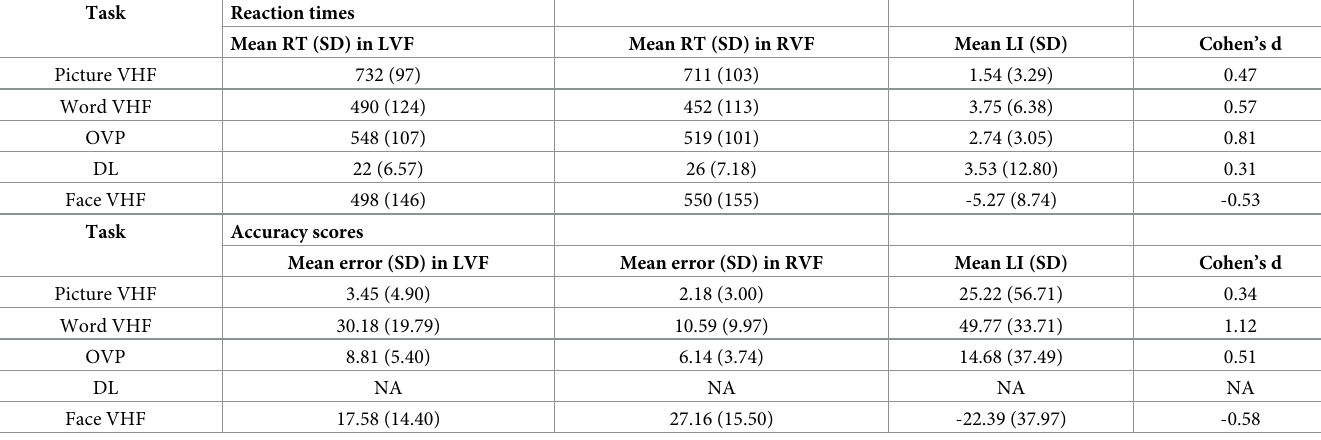
SD = standard deviation; LVF/RVF = left/right visual field respectively; VHF = visual half field; LI = lateralization index; OVP = Optimal Viewing Position; DL = Dichotic Listening.